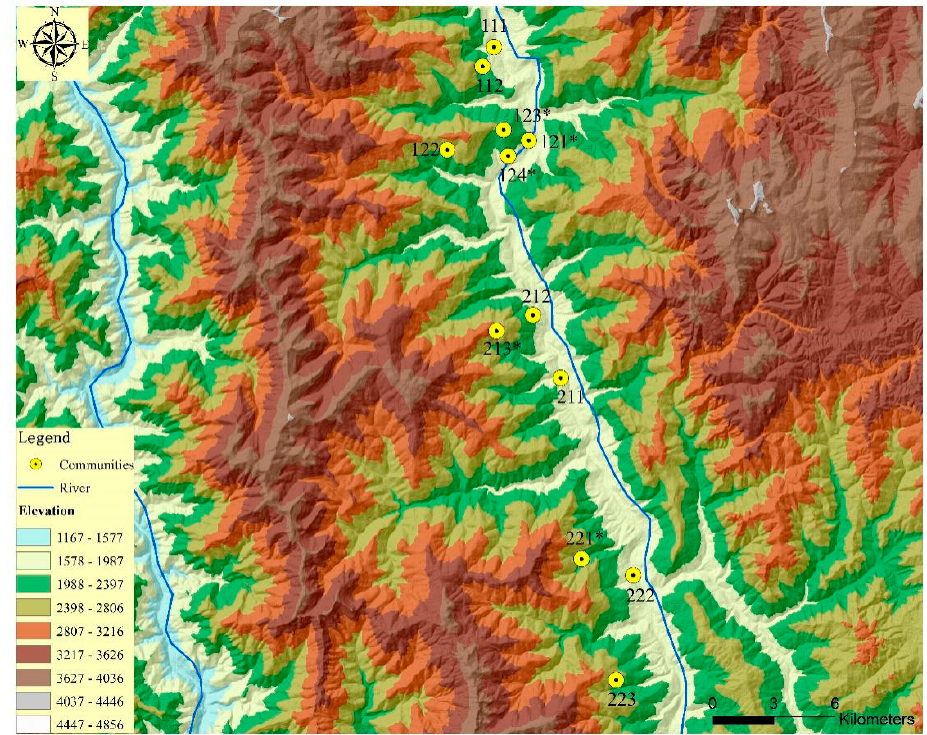
Figure 1. Study location. * indicates communities that implemented the Returning Farmland to Forest Program (RFFP).